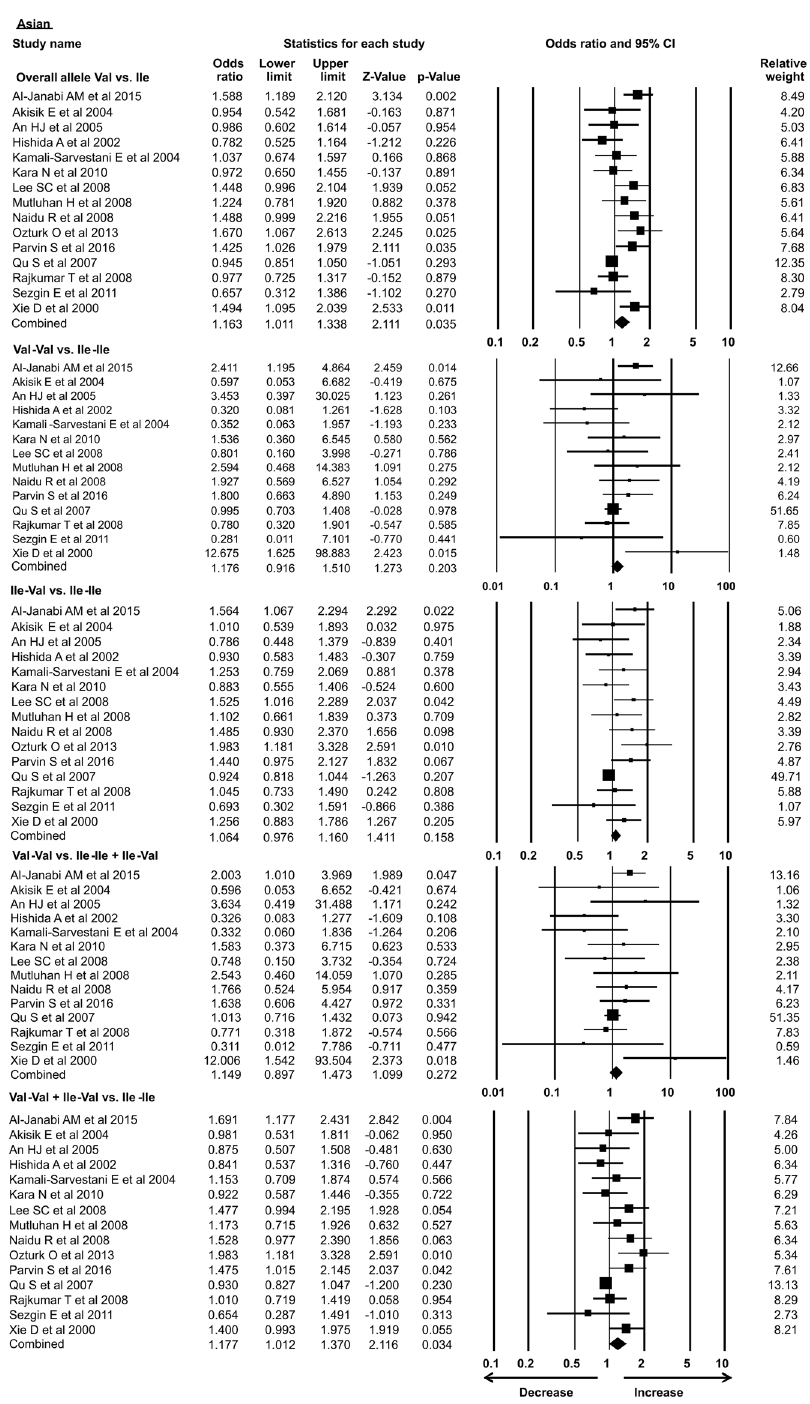
Figure 12. Forest plot: Overall analysis of Her2 Ile 655 Val (rs1136201) gene polymorphism data from Asian ethnic group for the evaluation of association with breast cancer susceptibility. Black squares represent the value of OR and horizontal line indicates 95% Confidence Interval (CI) of odds ratio